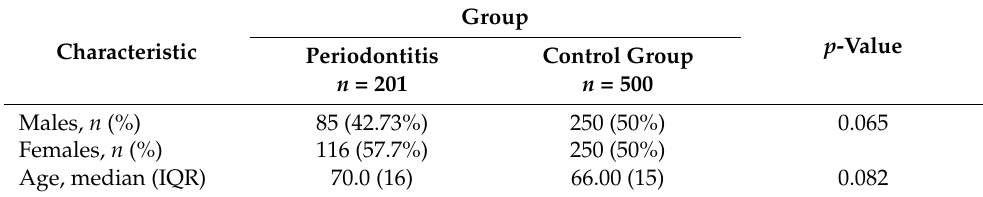
Table 1. Demographic characteristics of the study population.